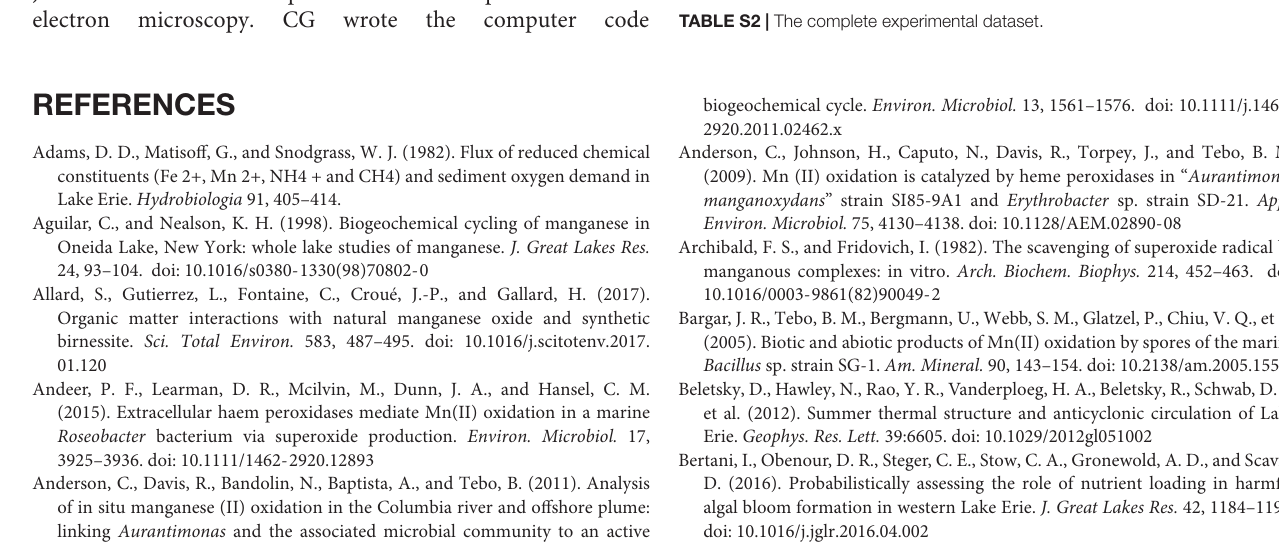
FIGURE S1 | EDS spectra collected on fiber like material produced under experimental conditions using water from the western basin amended with Mn and catalase (left) and water from the hypoxic hypolimnion of Lake Erie’s central basin (right). High Cu peaks are due to the copper grids used to prepare the samples for TEM. TABLE S1 | Summary data for each experimental unit. TABLE S2 | The complete experimental